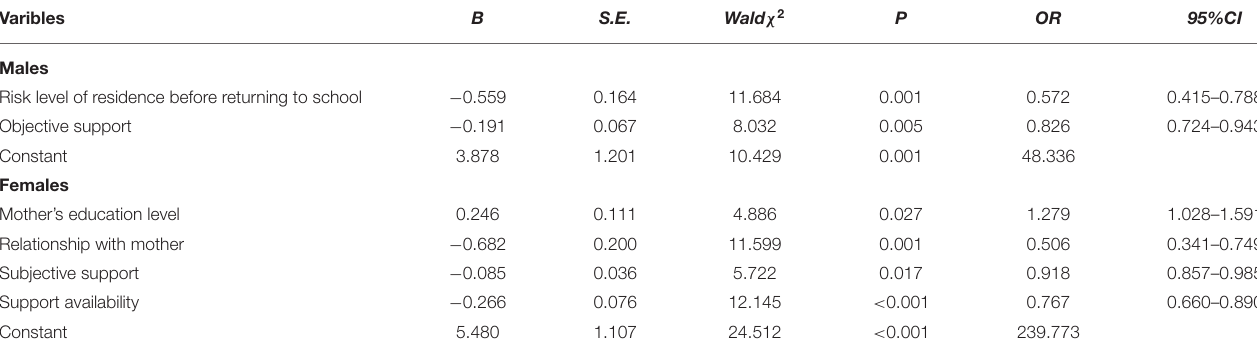
TABLE 3 | Multivariate logistic regression analysis of suicidal